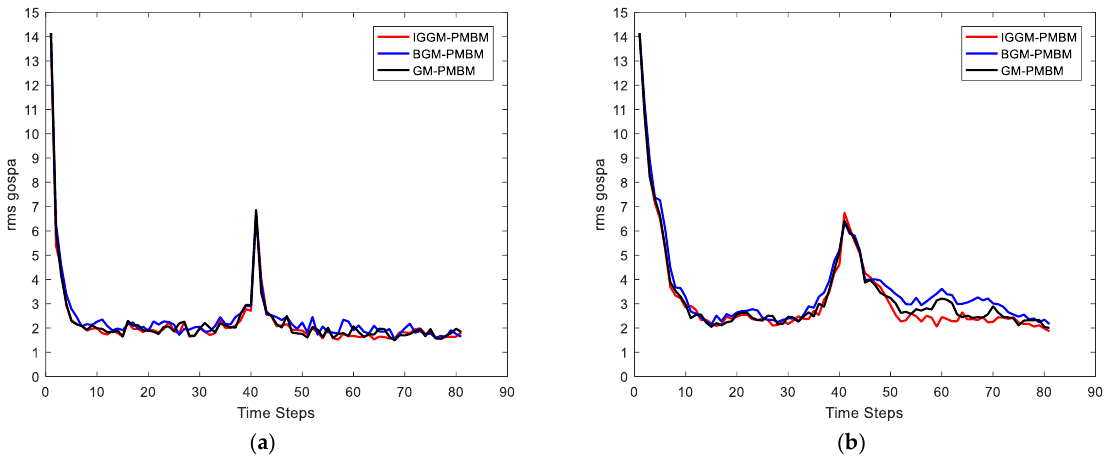
Figure 2. Average of GOSPA distances in 100 Monte Carlo runs. ( a ) 𝑃 𝐷 = 0.94 , 𝜆 𝜅 = 10 ; ( b ) 𝑃 𝐷 = Figure 2. AverageofGOSPAdistancesin100MonteCarloruns. ( a ) P D = 0.94, λ κ = 10; ( b ) P D = 0.68, λ κ = 0.68 , 𝜆 𝜅 = 10